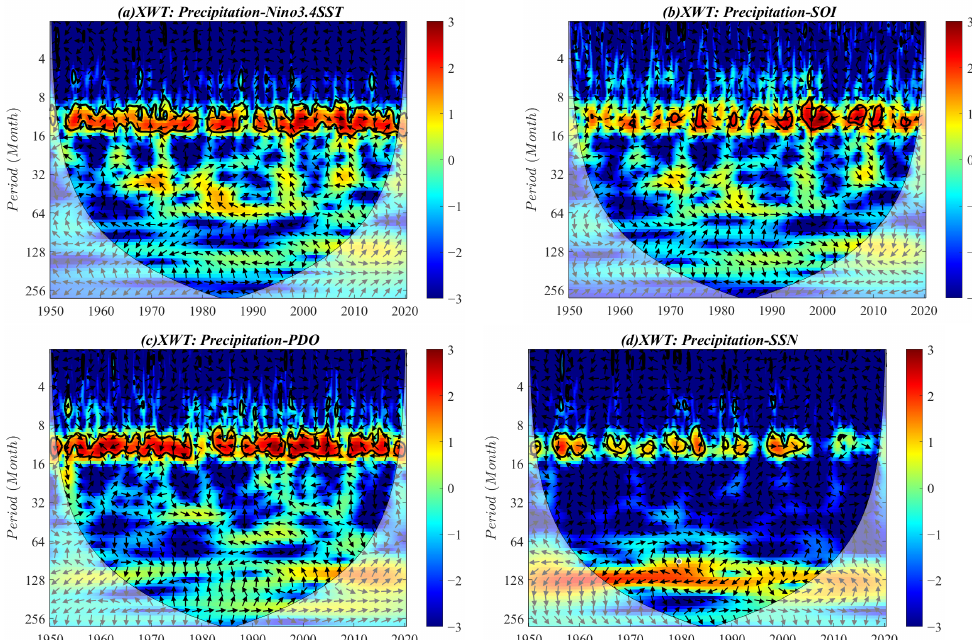
Figure 7. Cross wavelet power spectrums between monthly precipitation series and